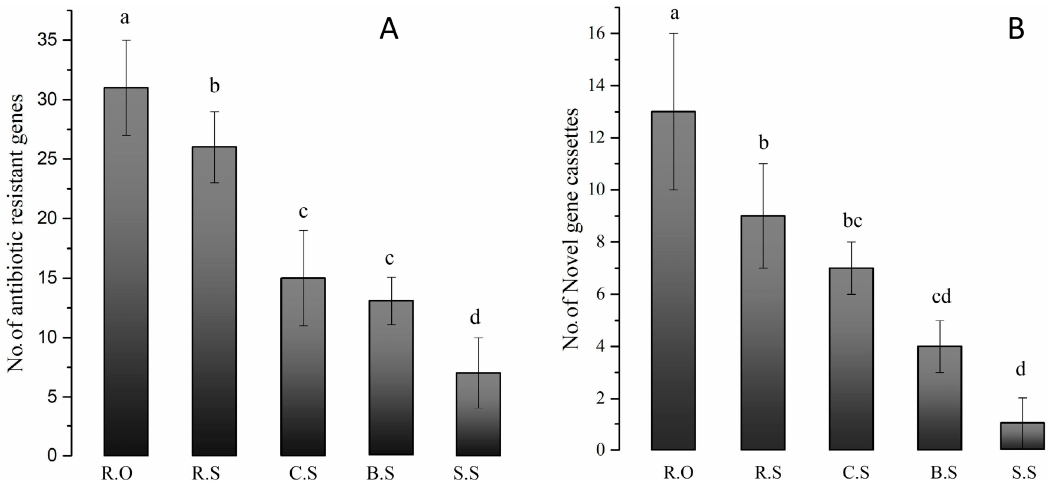
Figure 6. Numbers of antibiotic resistance genes ( A ) and novel GCs ( B ) observed in each sample. R.O—agriculture effluent site, R.S—rice field site, C.S—citrus field site, B.S—banana site, S.S—sugarcane sites. Different letters indicate different significant differences, while the error bars show the standard errors. Different letters (a, b, c, d) above the column indicate statistical significance at p values < 0.05. The highest number of antibiotic resistance GCs and novel GCs was found for the R.O site, and the lowest numbers were found for the S.S site.